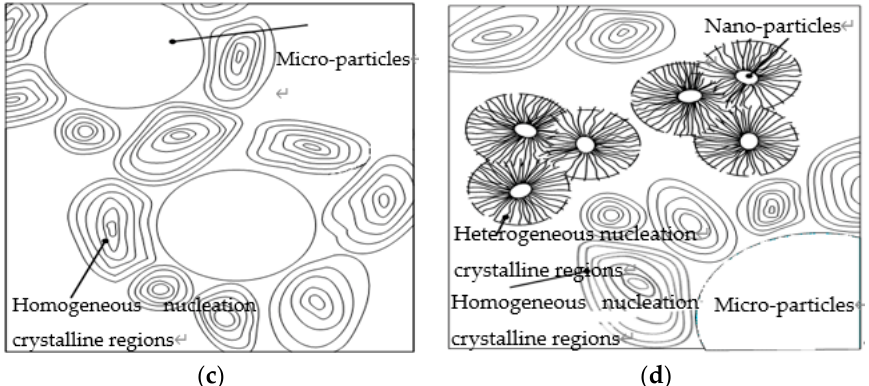
Figure 5. The structure model of Micro-Nano ZnO/LDPE composites. ( a ) LDPE; ( b ) N5; ( c ) M5; ( d ) N3M2.